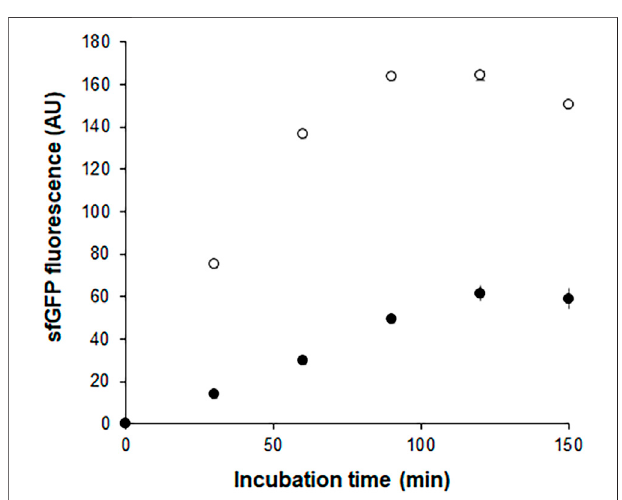
FIGURE 3 | Time courses of sfGFP synthesis during Indole-CCFPS and Trp-CCFPS assays. The CCFPS assay mixtures programmed with